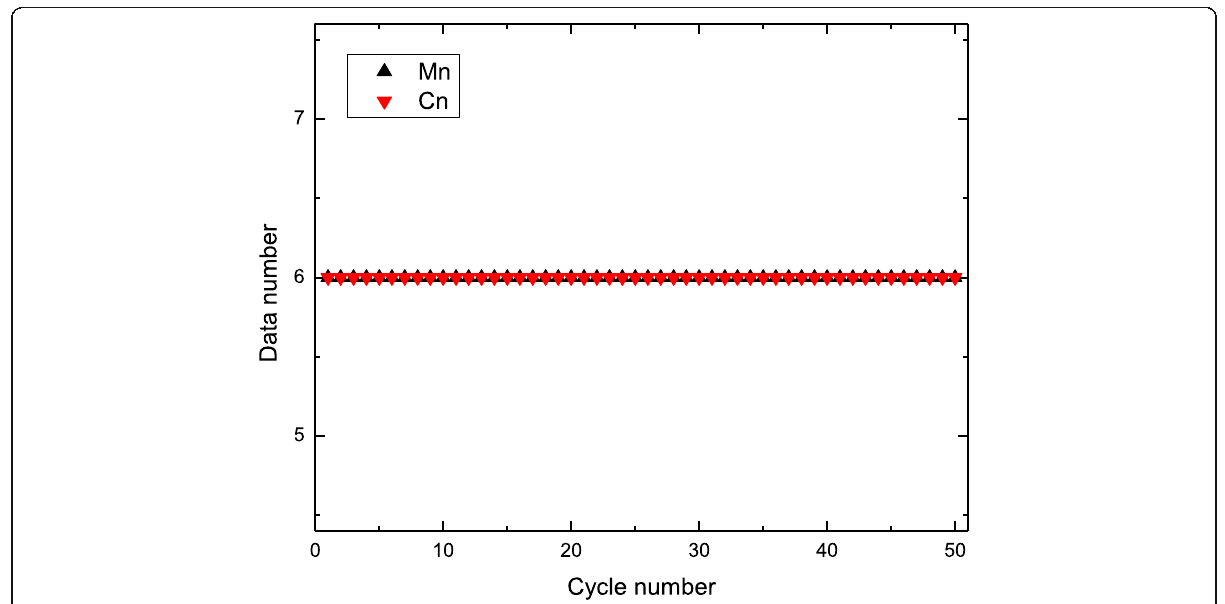
Fig. 28 The total volume of data is equal to 6 in each cycle; Mn and Cn in the first 50